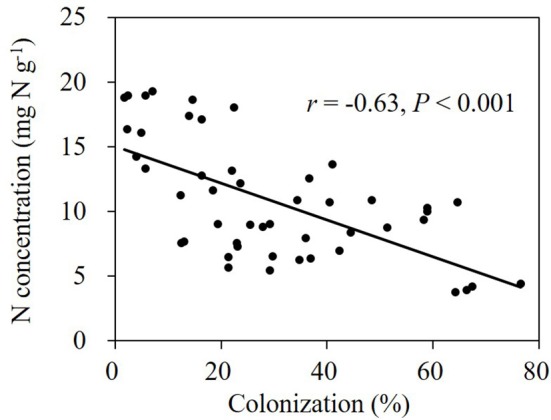
Relationship between shoot N concentration and mycorrhizal colonization by native AMF community in the field experiment in 2008 (Person, P < 0.05).